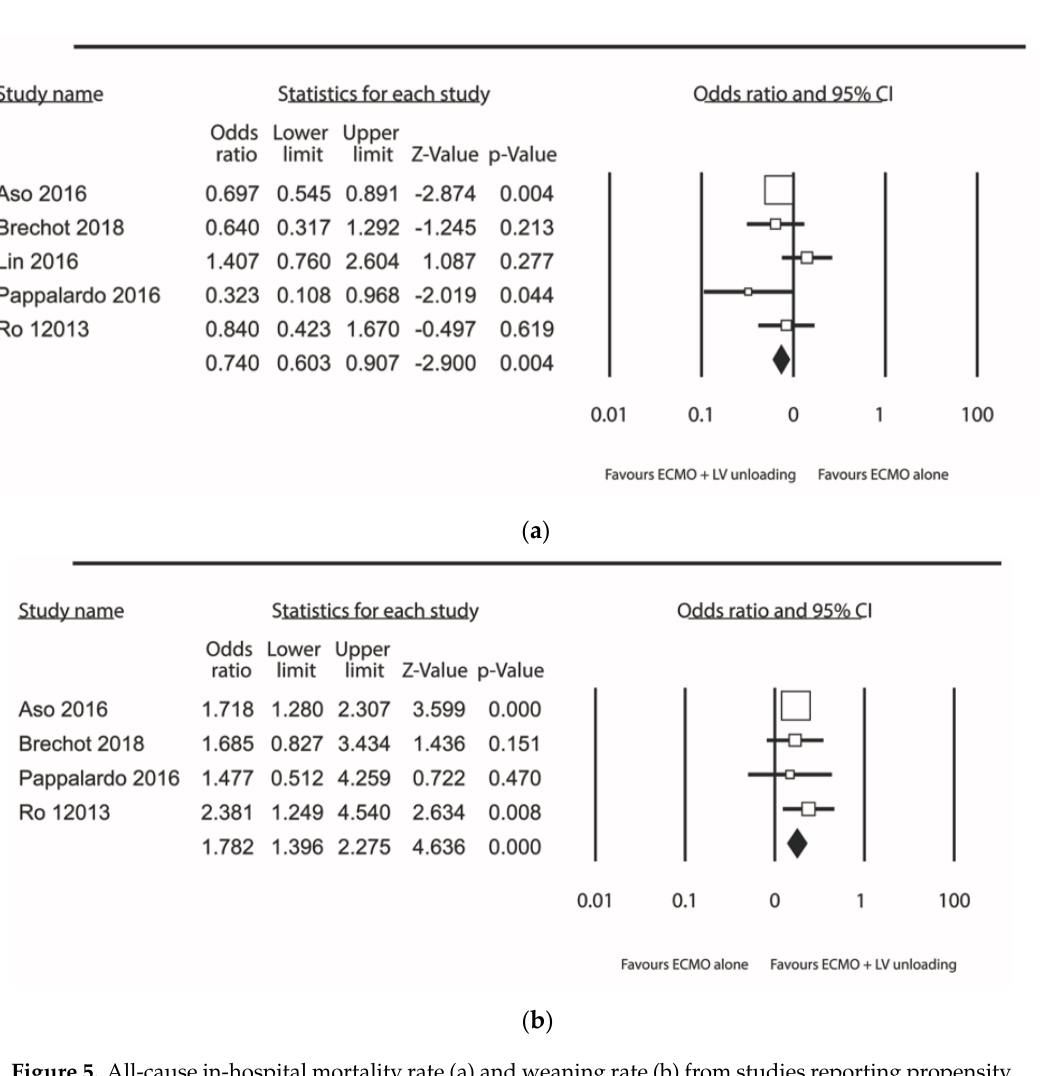
Figure 5. All-cause in-hospital mortality rate (a) and weaning rate (b) from studies reporting propensity adjusted results.